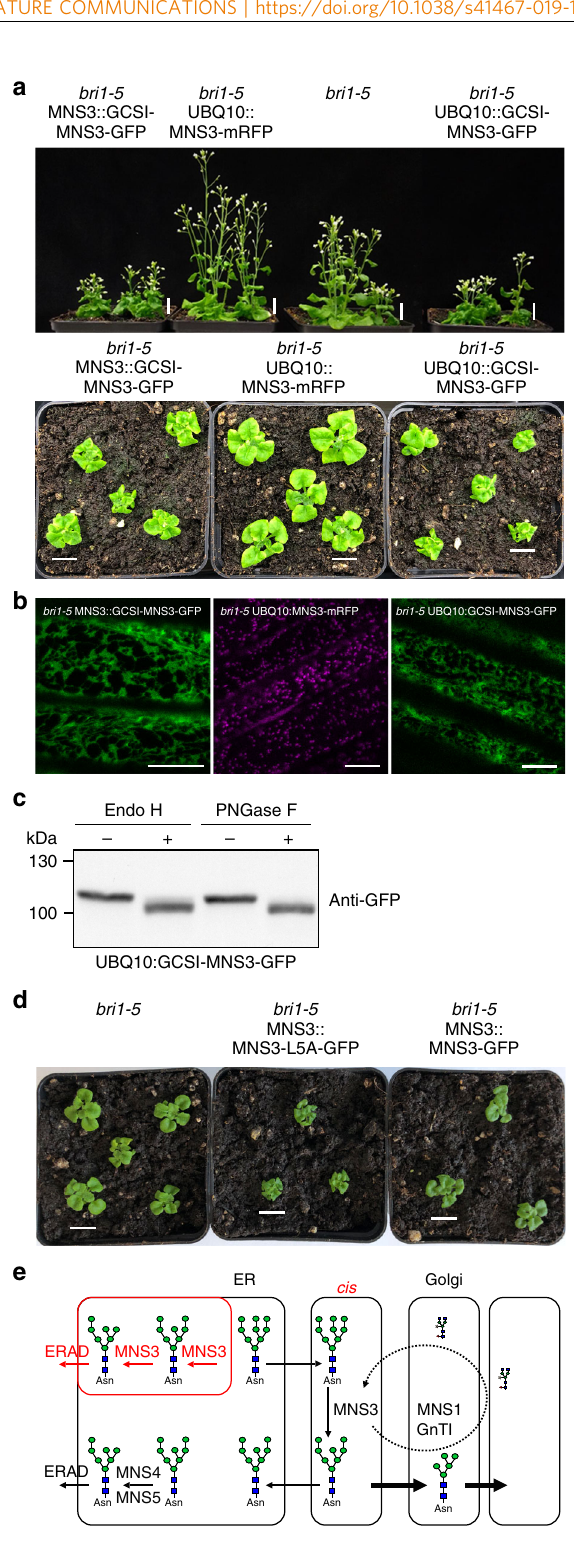
Plasmid construction and generation of transgenic plants . The following constructs have been published previously: MNS3-GFP (p20-MNS3 7 ), MNS3-CTS- GFP (p20-MNS3-CTS 7 ), MNS1-GFP (p20-MNS1 24 ), MNS1-mRFP (p31-MNS1 24 ), STtmd-mRFP 27 , GnTI-mRFP (p31-GnTI 11 ), GFP-AtCASP 71 , mRFP-AtCASP 72 , AtERD2-GFP 73 , and SAR1-GTP 12 . Unless stated otherwise, fusion proteins were expressed under the control of the cauli fl ower mosaic virus 35S promoter. To generate the vector p62 for expressing GFP-HDEL tagged fusion proteins, the expression cassette of the plant expression vector p61 that contains a custom-made 3×HA-HDEL sequence (GeneArt-Gene Synthesis) was removed by HindIII/EcoRI- digestion and cloned into the HindIII/EcoRI-site of vector p27. This vector is